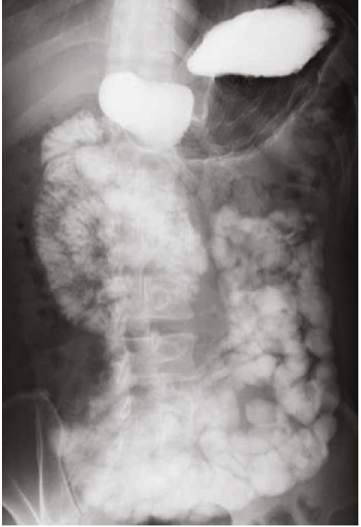
Figure 2: Upper GI series revealed that the duodenal descending section and the jejunum are located in the right upper abdomen, and the remaining intestine runs from the lower right abdomen to the left